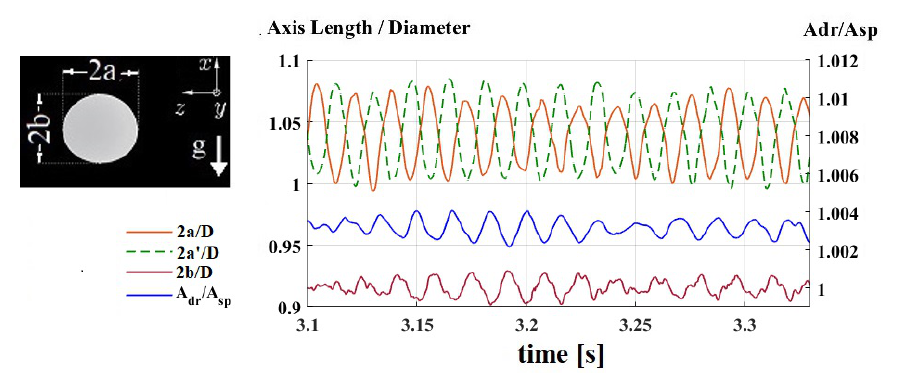
Figure 6. Temporal variations in the axis lengths and surface area of the simulated 3 mm water drop in stagnant